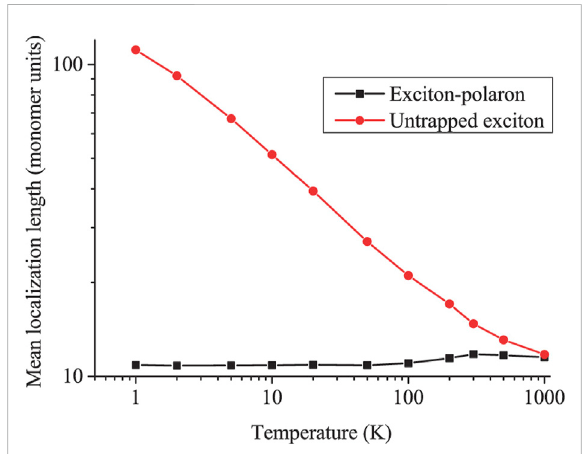
FIGURE 10 The exciton localization length as a function of temperature for the “ free ” (i.e., “ untrapped ” ) exciton (red circles) and exciton- polaron (i.e., “ self-trapped ” ) (black squares). Increasing the temperature causes a minor increase in the size of the exciton-polaron. This increase in size arises from the exciton escaping from the polaron potential well and being excited into a LEGS or QEES. The polaron binding energy is high enough for excitons in PPP that this is a rare occurrence even at high temperatures. The untrapped exciton localization length obeys L free ∝ T − 1/3 . The lengths coincide when k B T ~ the exciton-polaron loc binding energy. Reproduced from J. Chem. Phys. 143, 084102 (2015) with the permission of AIP